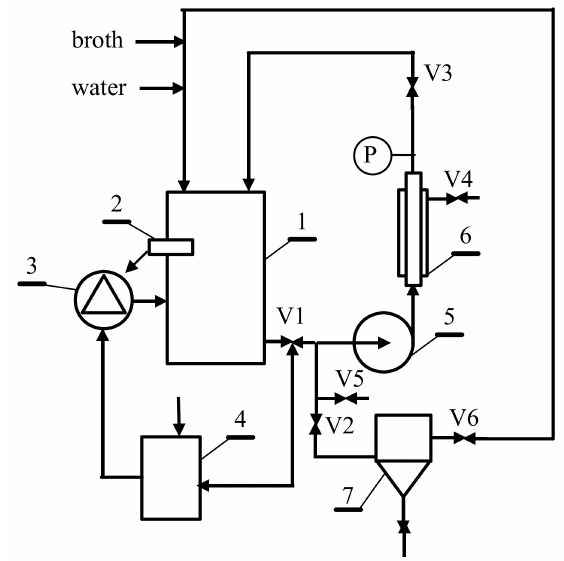
Figure 10. The technological conception of UF installation with a membrane-cleaning system